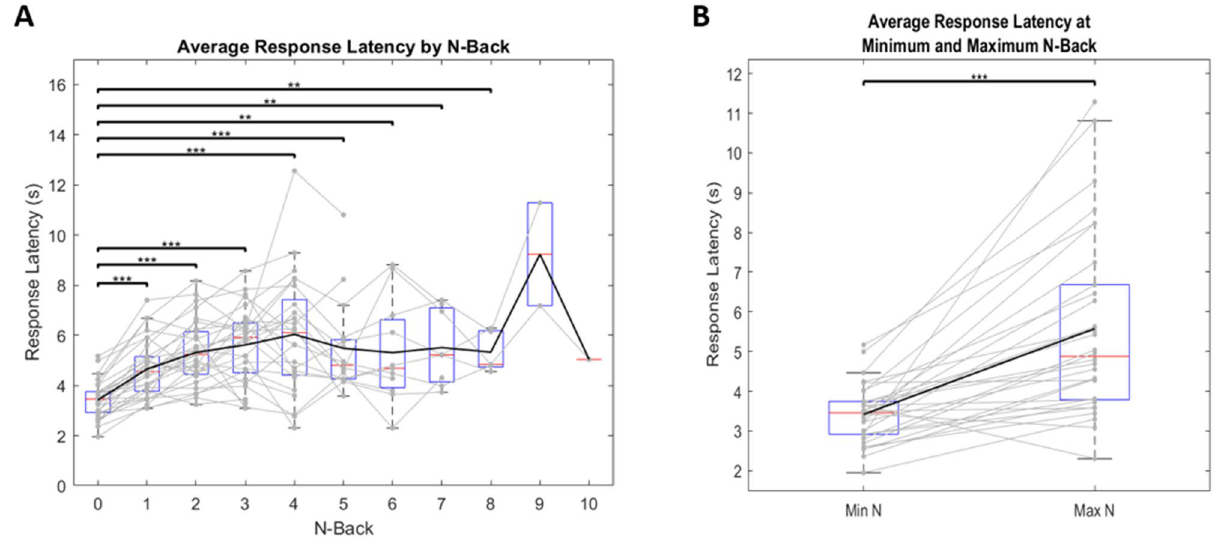
Figure 4. Response latency across N-back. Black line represents mean values. Solid gray lines represent individual subjects. Red lines represent median values. Blue boxes represent the IQR where each lower bound signifies Q1 and each upper bound signifies Q3. Lower and upper bounds of grey dotted lines represent minimum and maximum values, respectively. Points that lie outside these bounds are considered outliers. One star represents a significance value of p < 0.05, two stars represents a significance value of p < 0.01, and three stars represents a significance value of p < 0.001. ( A ) Demonstrates the average response times across each N-back. For clarity, only interactions against N = 0 are plotted here. ( B ) Demonstrates the average response latency at each subject’s minimum N-back (N = 0 for all subjects), compared to their maximum N-back (variable across